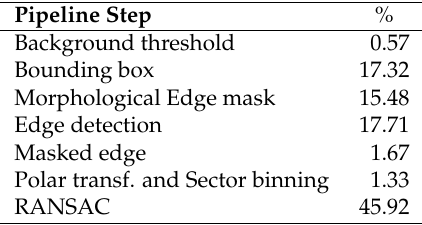
Table 2. Relative amount of execution time for each step in the processing